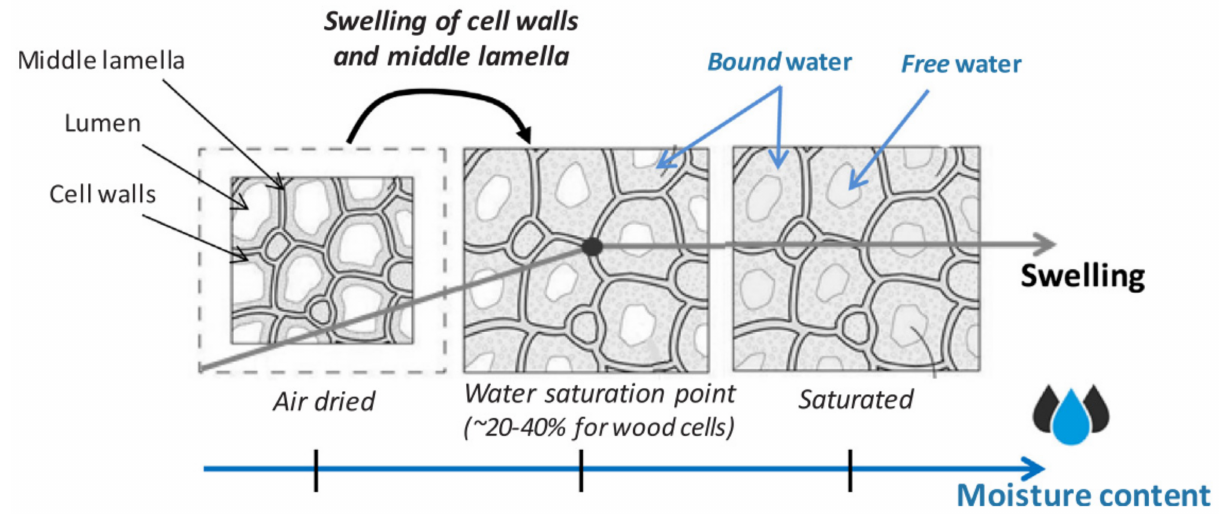
Figure 3. The swelling and water state based on the moisture content in natural fiber cells. Adapted from ref.